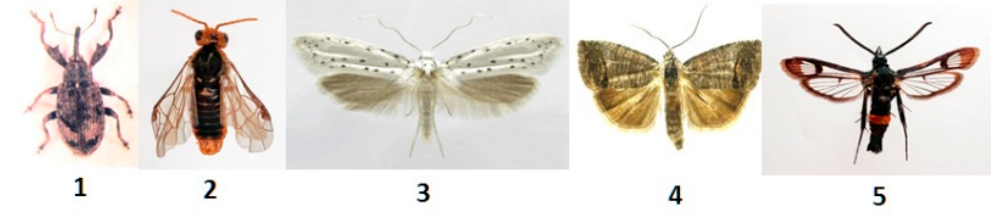
Figure 1. Selected 5 pests of apple tree orchards [6].